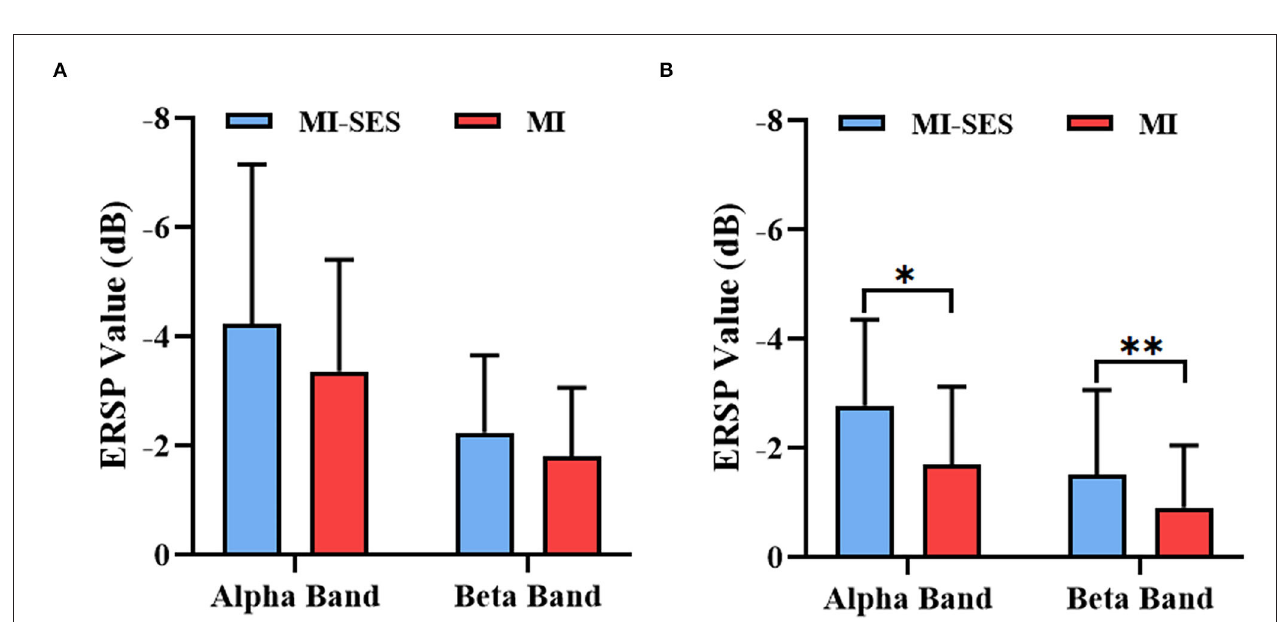
FIGURE 4 | The average time-frequency maps over C3 channel for all High Performers and all Low Performers. The period [1 5] s indicated the MI or rest task. The period [3 5] s corresponds to st-SES in MI-SES and SES conditions.